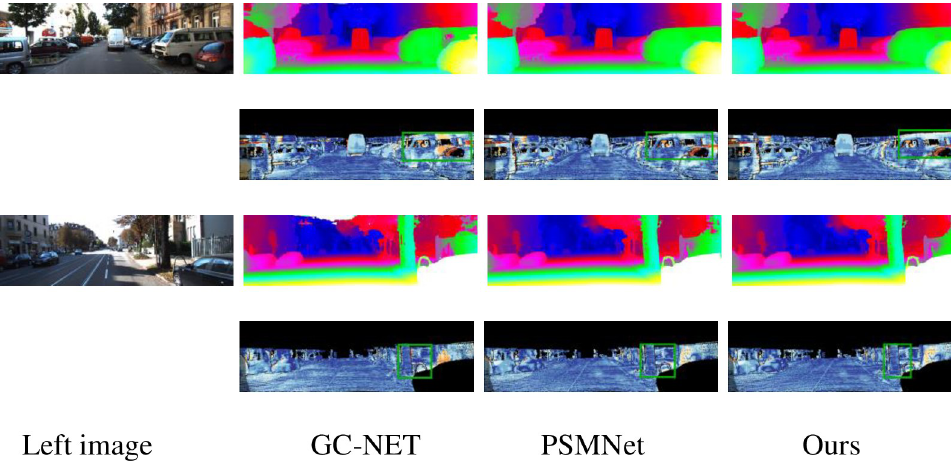
Fig 6. Qualitative evaluation results on the KITTI 2015 dataset. The first column shows the left images. For each photo, the first row shows the pseudocolor images for predicting the disparity map, and the second row shows the error maps. From left to right are the results of GC-NET [18], PSMNet [13], and our method, respectively.